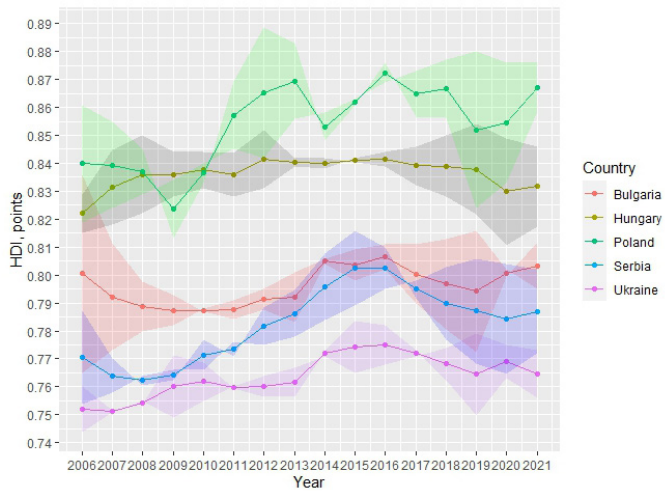
Figure 5. Fitted values of models, Hypothesis 1 (correlation between budget deficit, public debt and HDI), with standard error intervals